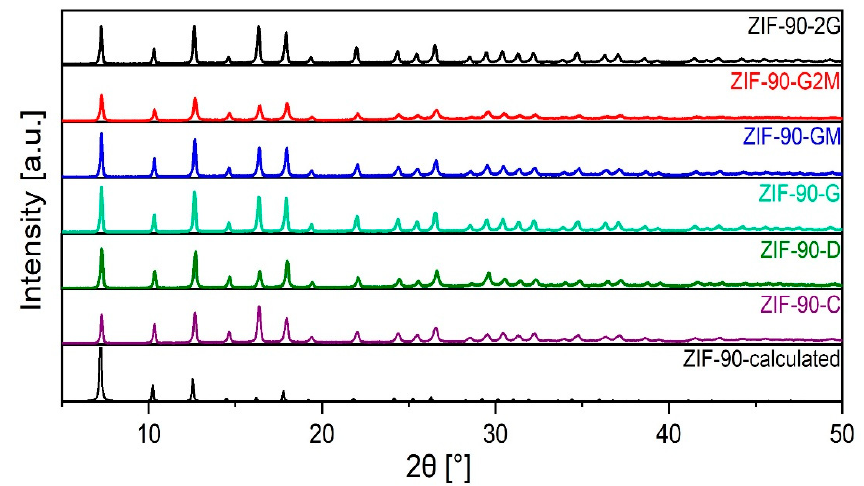
Figure 1. Powder X-ray diffraction data (PXRD) of synthesised ZIF-90. The samples were further investigated by SEM imaging of ZIF-90-D, ZIF-90-C, ZIF- 90-G, ZIF-90-2G, ZIF-90-GM, and ZIF-90-G2M (Figure 2). Again, all products appeared